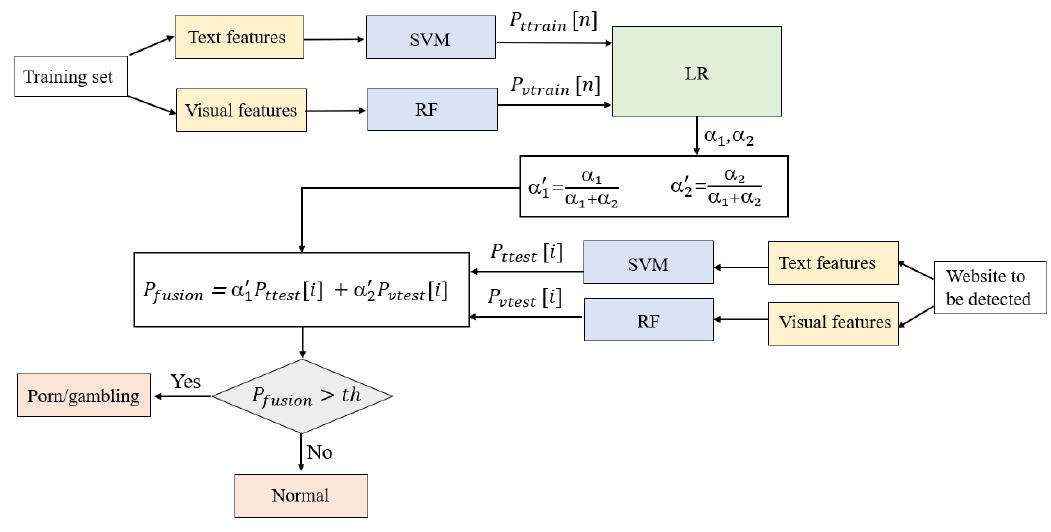
Figure 4. The flowchart of the classification algorithm.